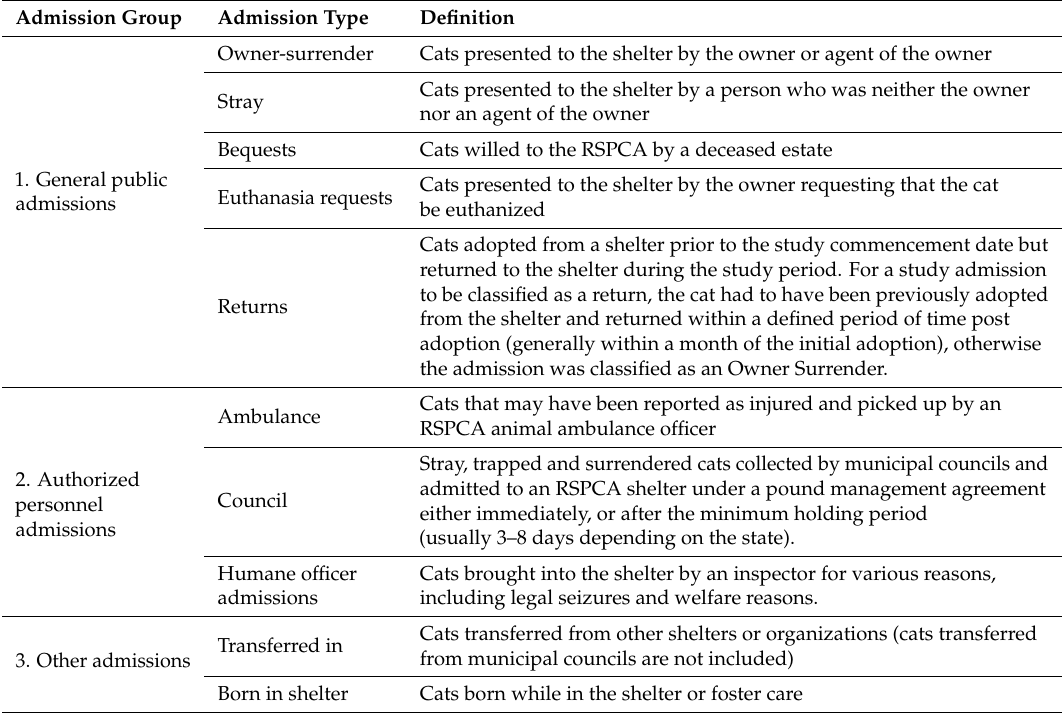
Table 1. Admission source groups, categories and definitions for cats admitted to 39 Royal Society for the Prevention of Cruelty to Animals (RSPCA) shelters between June 2006 and July